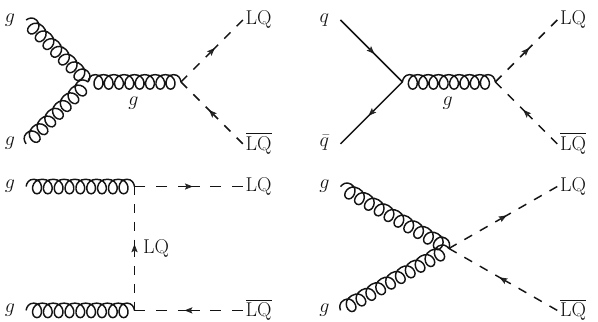
Fig. 1 Dominant leading order Feynman diagrams for the production of leptoquark pairs in proton–proton collisions